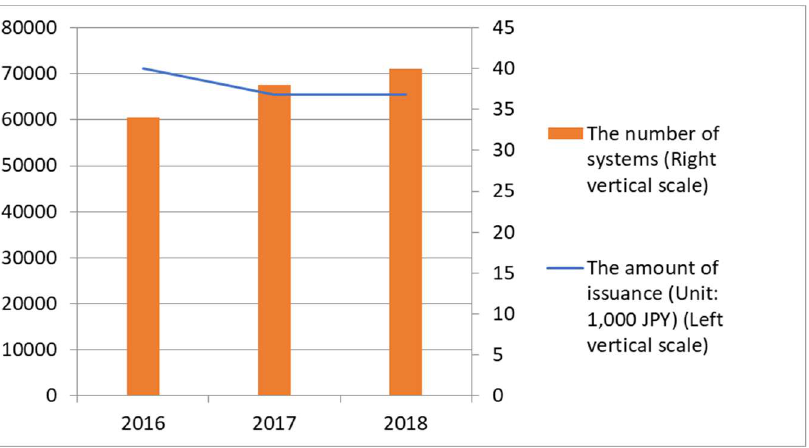
Figure 3. The value of community currency issued by Ki-no-Eki ( Source : Izumi and Nakazato [7] (p. 161)).